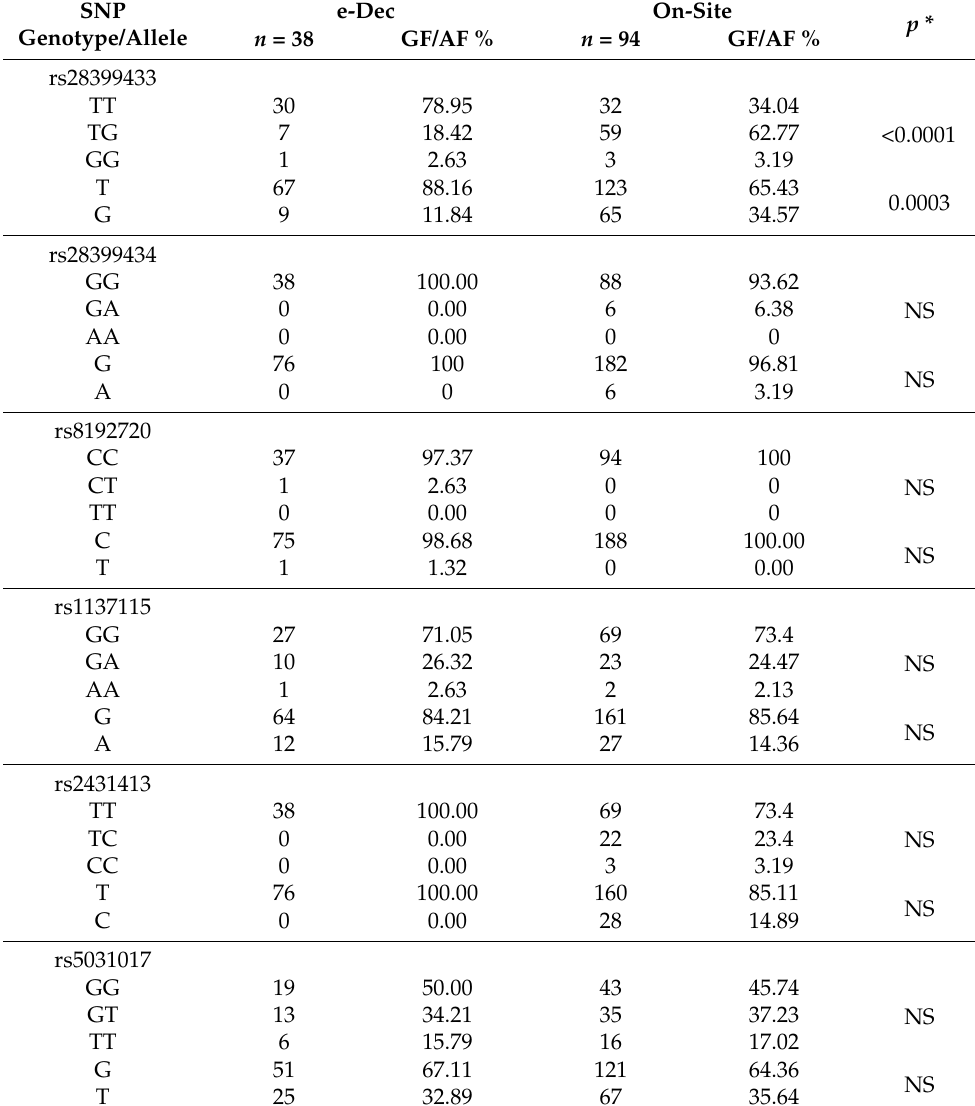
Table 4. Genotype and allele frequencies in both groups included in this study only in six SNPs of CYP2A6